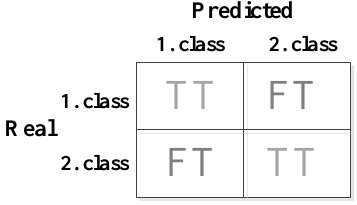
Fig. 2. Confusion matrix for evaluation of 2 target class identification. The number of matrix columns and rows in the table is equal to the number of target classes. The elements on the matrix diagonal represent the number of correctly identified images ( True True ( TT )), but the rest represents the number of incorrectly identified classes ( False True ( FT